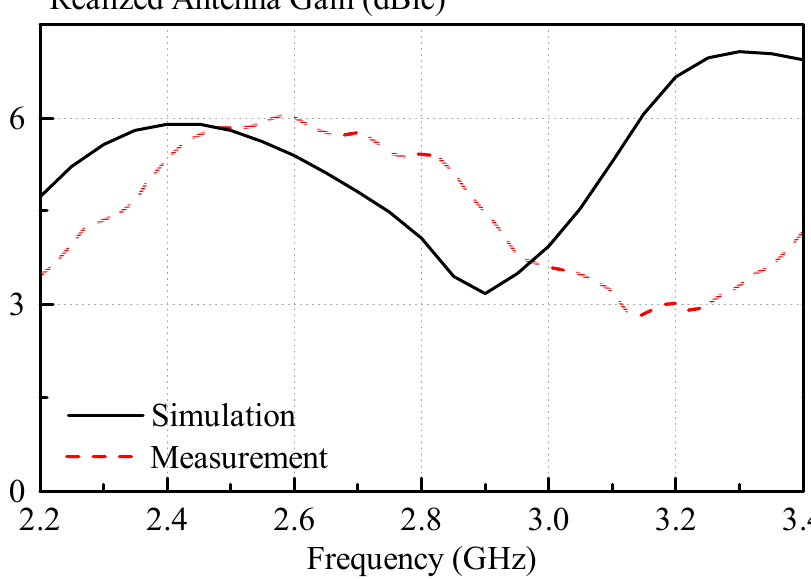
Figure 14. Measured and simulated gain of the right hand circularly polarized antenna.